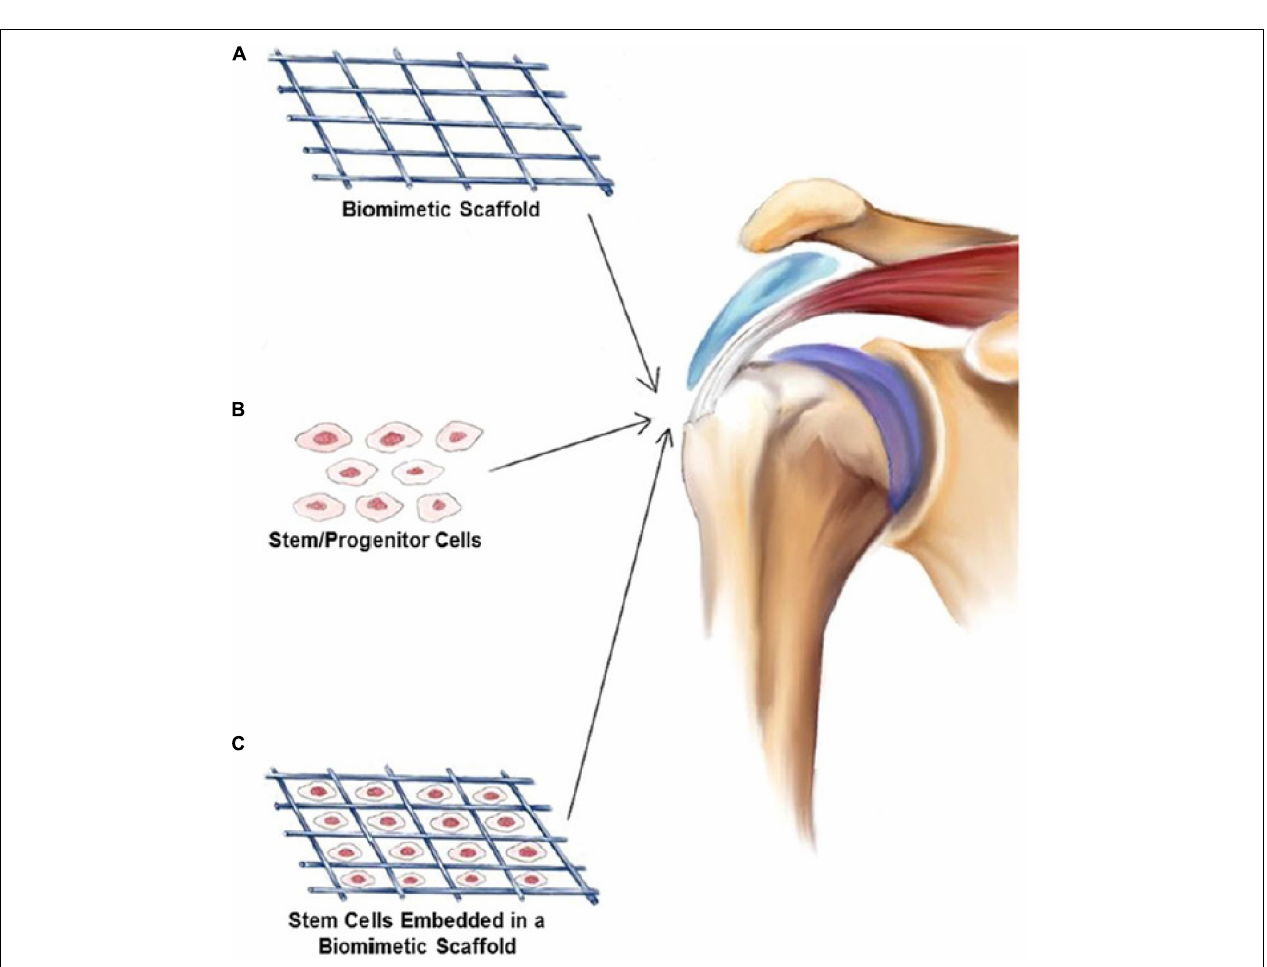
FIGURE 8 | Stem cells can be combined with biomimetic scaffolds and then implanted into injured site for rotator cuff repair (Bianco et al., 2019). (A) Biomimetic Scaffold. (B) Stem/Progenitor Cells. (C) Stem Cells Embedded in a Biomimetic Scaffold.